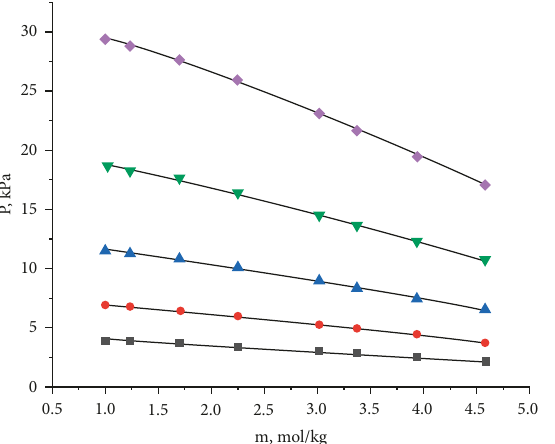
Figure 9: Calculation of the VLE for the CaBr2+H2O system. Symbols ( , T � 303.15K; , T � 313.15K; , T � 323.15 K; , T � 333.15K; and , T � 343.15K :); VLE data; lines: calculation.